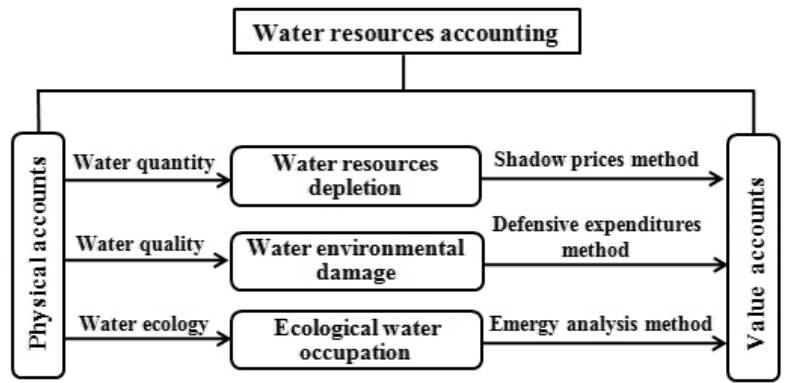
Figure 1. Technical routes of water resources